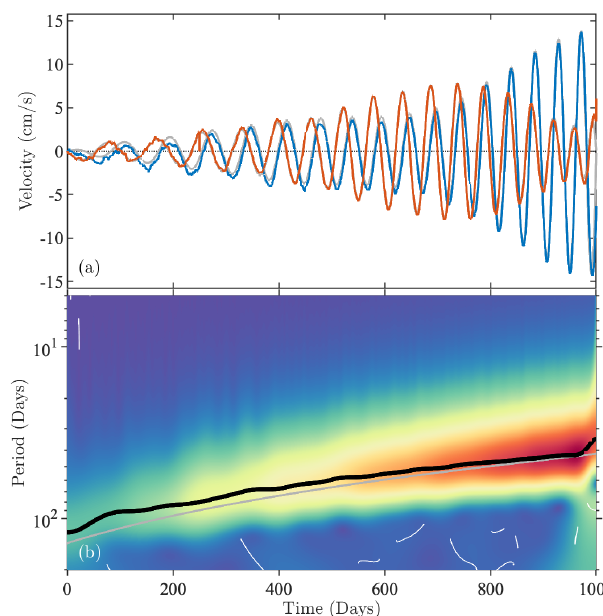
Figure 8. Multivariate wavelet ridge analysis applied to the syn- thetic composite signal shown in Fig. 5a. Panel (a) is the velocity corresponding to the displacement signal, with blue for the east- ward component and orange for the northward component. The magnitude of the wavelet transform (cid:107) w (t,s) (cid:107) of the displacement signal using a (β,γ) = ( 2 , 3 ) generalized Morse wavelet is shown in (b) , with the heavy black curve denoting a major ridge and the white curves denoting short, spurious ridges arising as a result of the stochastic background process. The period corresponding to the generating parameters is shown as the gray line; see Appendix A. The gray lines in panel (a) are the velocity components formed by differentiating the ridge-based estimate of the oscillatory displace- ment signal (cid:98) x (cid:63) (t) that is found as the real part of Eq. (54); these are very close to the original signal and are not visible for most of the record because they are overplotted by the blue and orange